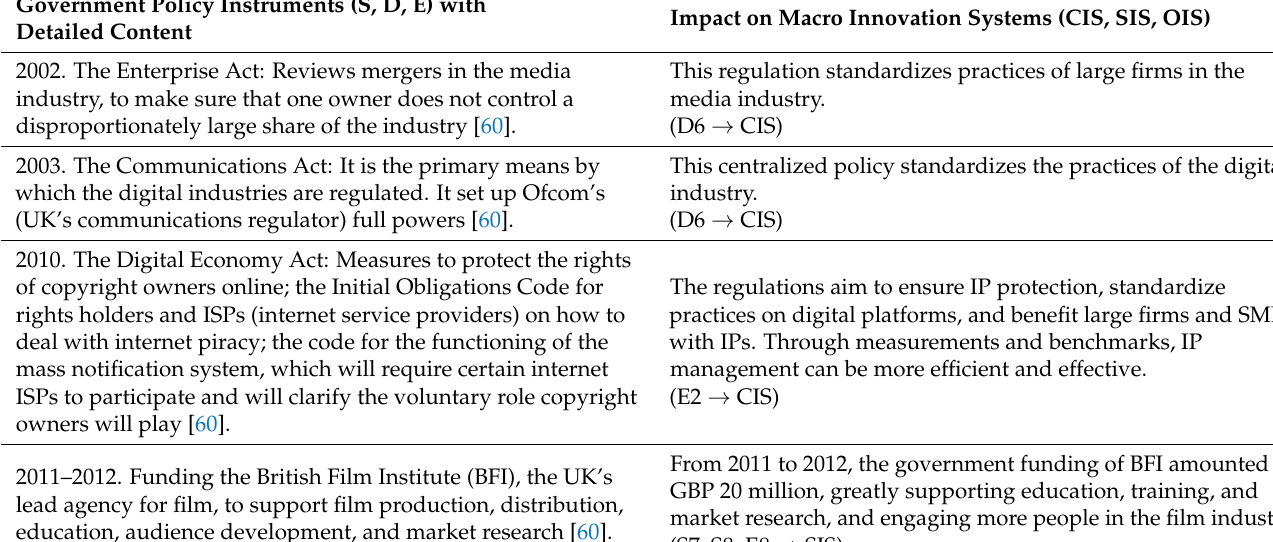
Table 4. Analysis of animation industry-related policies in the